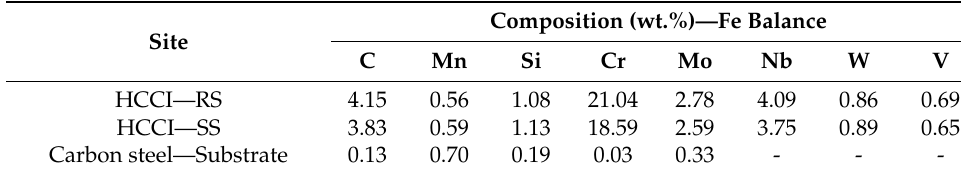
Table 1. Chemical composition (wt.%) of the hardfacing